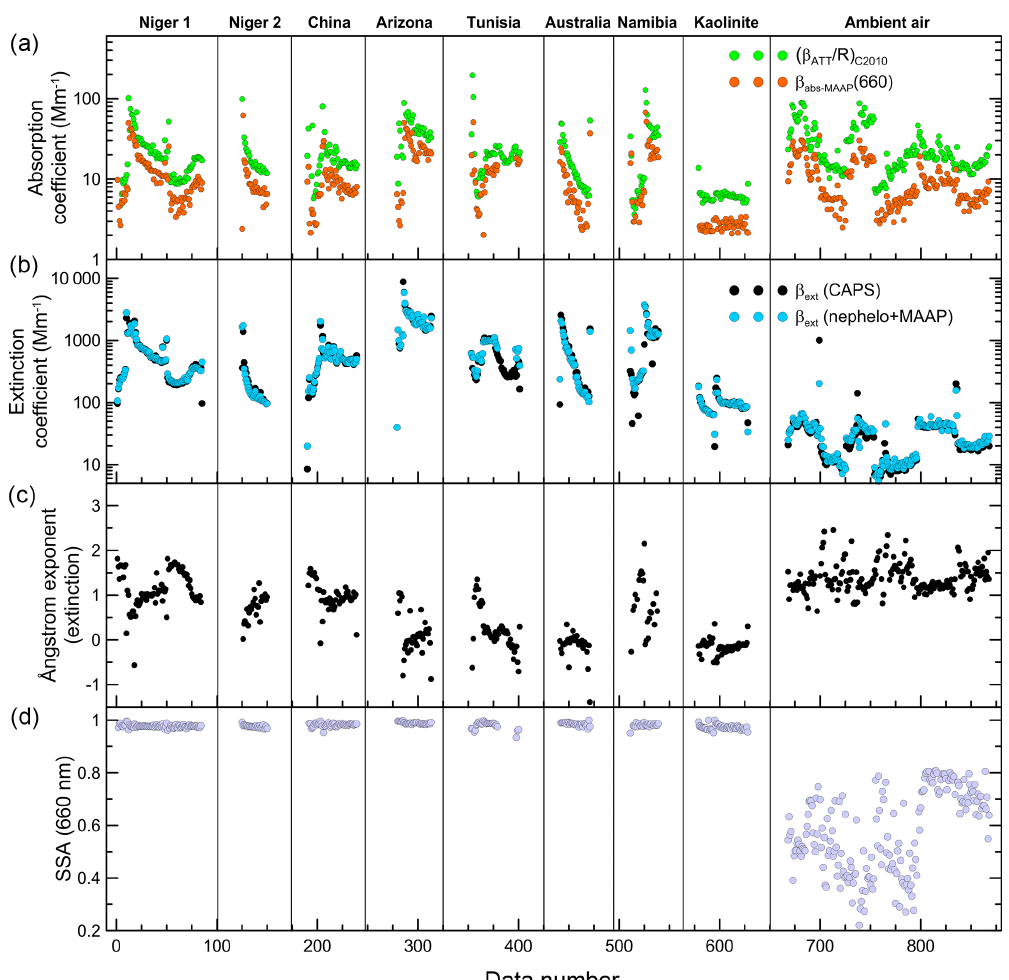
Figure 2. Temporal series of experiments showing the measured optical data at 660nm. The different panels show (from the top to the bottom): (a) the loading-corrected Aethalometer attenuation at 660nm (data corrected with the R formulation by Collaud Coen et al. (2010) (referred to as R (C2010)) are shown) and the MAAP aerosol absorption coefficient; (b) the aerosol extinction at 660nm extrapolated from CAPS PMex measurements and estimated as the sum of nephelometer scattering and MAAP absorption; (c) the extinction aerosol Ångström exponent; (d) the aerosol single scattering albedo at 660nm. Each point in the plot corresponds to 2min average data. The x axis indicates the data point sequential number. Experiments with dust samples and kaolinite occurred between the 3 and the 9 November 2016 and lasted between 1 and 2h each. Ambient air data were collected at different steps between the 8 and the 14 November 2016 for a total of 7h of